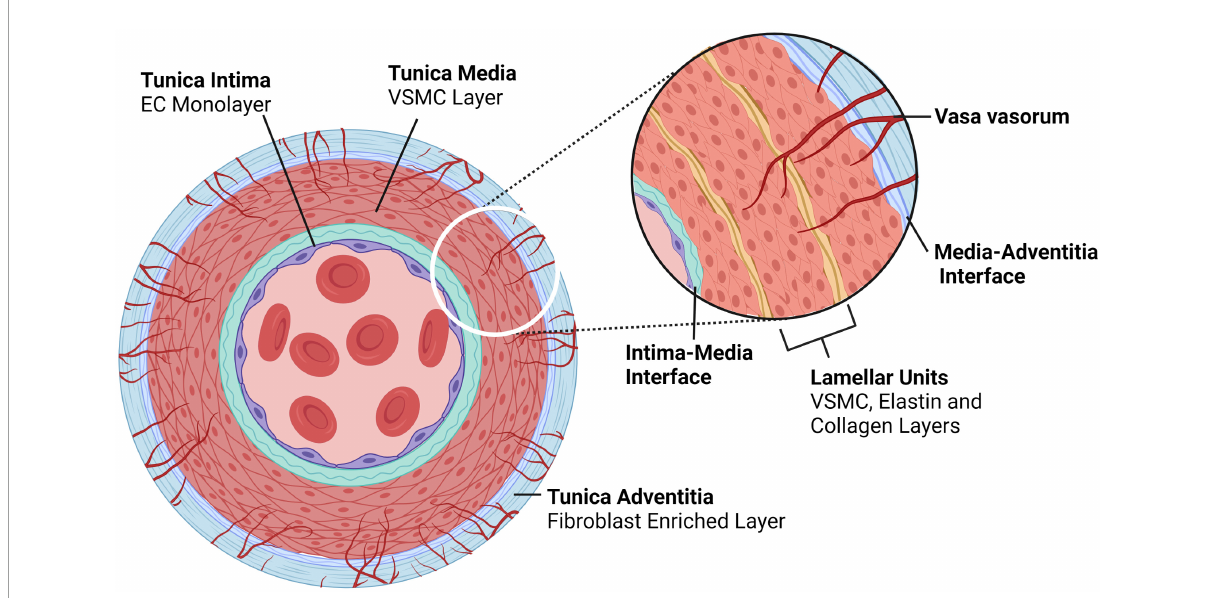
FIGURE2 Typical architecture of medium to large, elastic and muscular arteries. Arteries comprise of three layers – the tunica intima is the innermost layer consisting of an endothelial monolayer; abluminal this monolayer is an ECM membrane located between the intima and the media, the latter being the second layer of the artery. The tunica media is concentrically layered with lamellar units of VSMCs bounded by elastin- and collagen-rich fibers. In larger arteries, the media is perfused by capillaries known as vasa vasorum, which enter the media through the outermost layer, the tunica adventitia; an ECM and fibroblast-rich layer. Created with